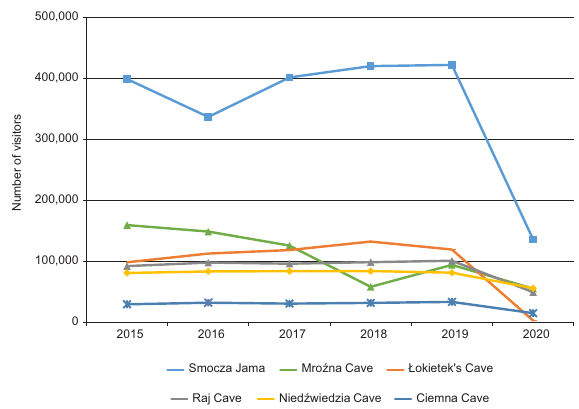
Fig. 7. Numbers of visitors to less popular